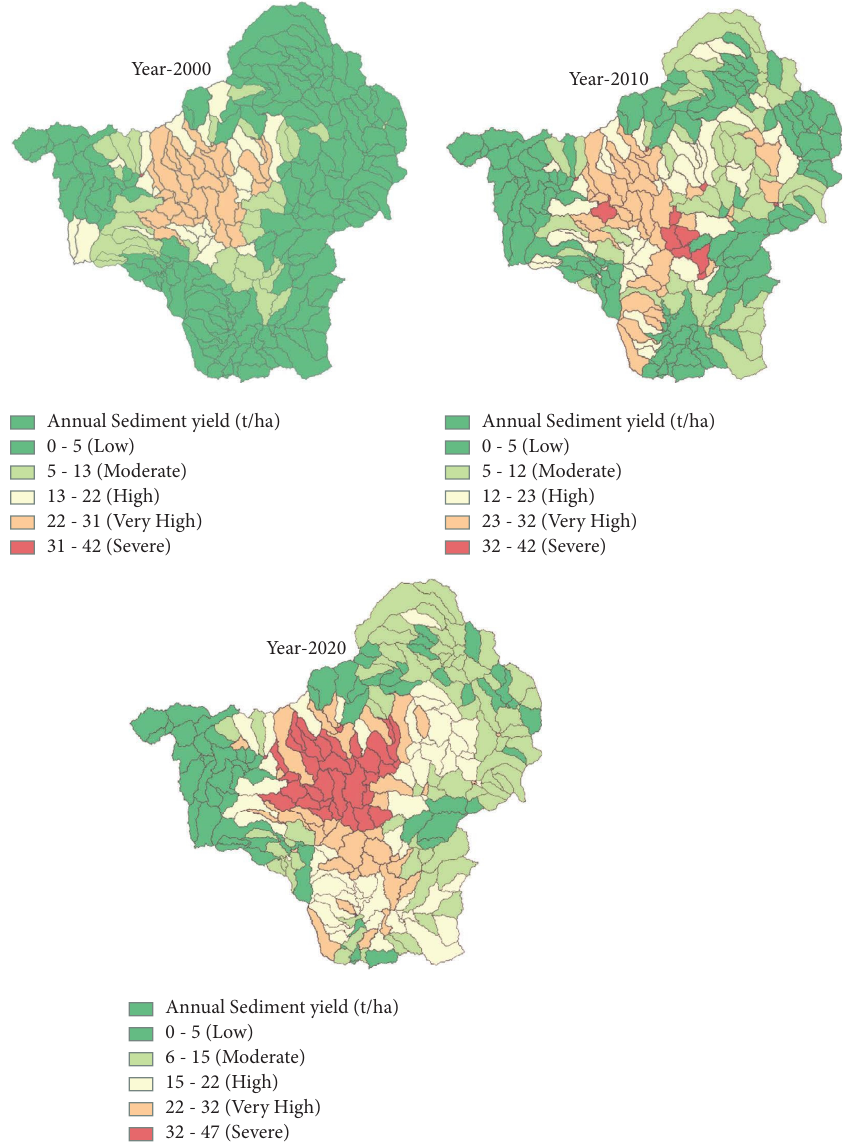
Figure 12: Spatial map of soil erosion-prone LSUs at subwatershed levels. Table 12: Soil erosion-prone landscape units (LSUs) in the watershed with sediment yield (t/ha). S 1